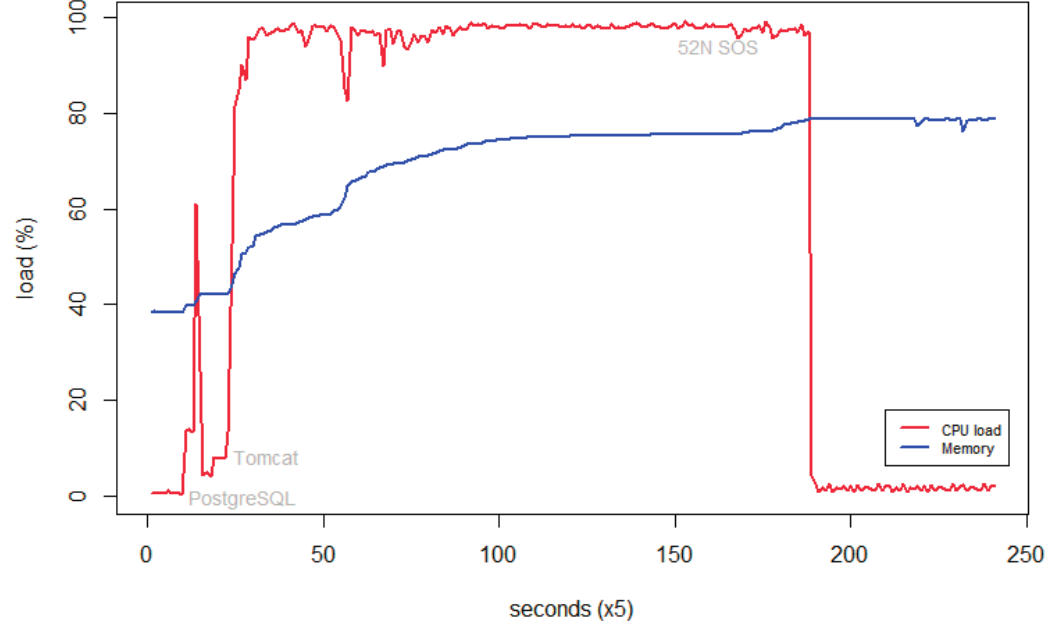
Figure 5. RaspberryPI memory and processor loads prior to